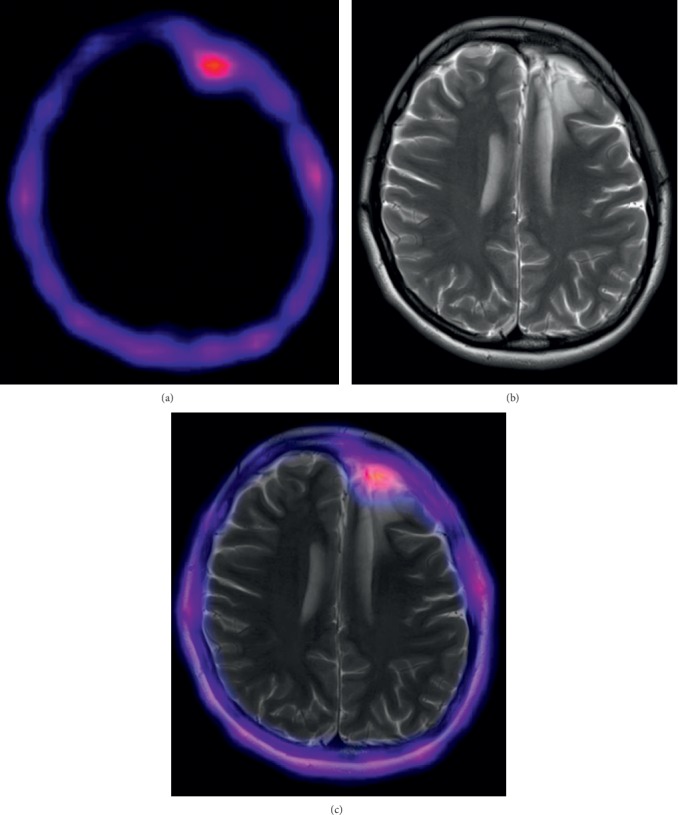

99mTc-CXCR4-L SPECT (a), MRI (b), and SPECT/MRI (c) of a diffuse astrocytoma NOS (tumor recurrence) with T/Bmax 3.9 (patient 7).